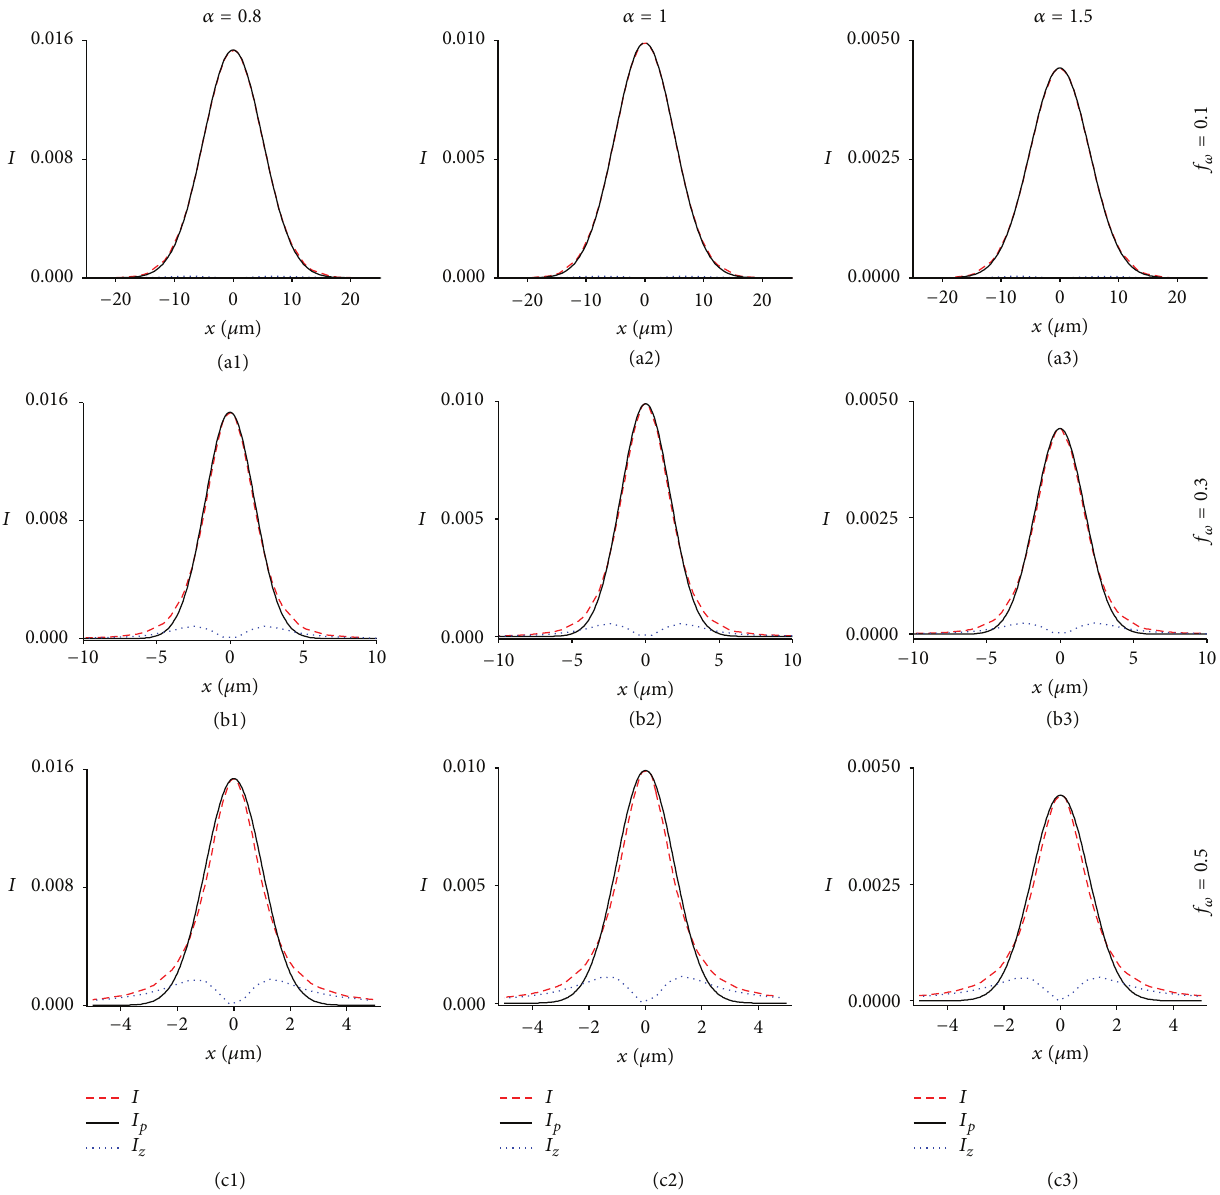
𝛼 : (a1) 𝑓 = 0.1 , 𝛼 = 0.8 ; (b1) 𝑓 = 0.3 , 𝛼 = 0.8 ; (c1) 𝑓 = 0.5 , 𝛼 = 0.8 ; (a2) 𝑓 = 0.1 , 𝛼 = 1 ; (b2) 𝑓 = 0.3 , 𝛼 = 1 ; 𝜔 𝜔 𝜔 𝜔 𝜔